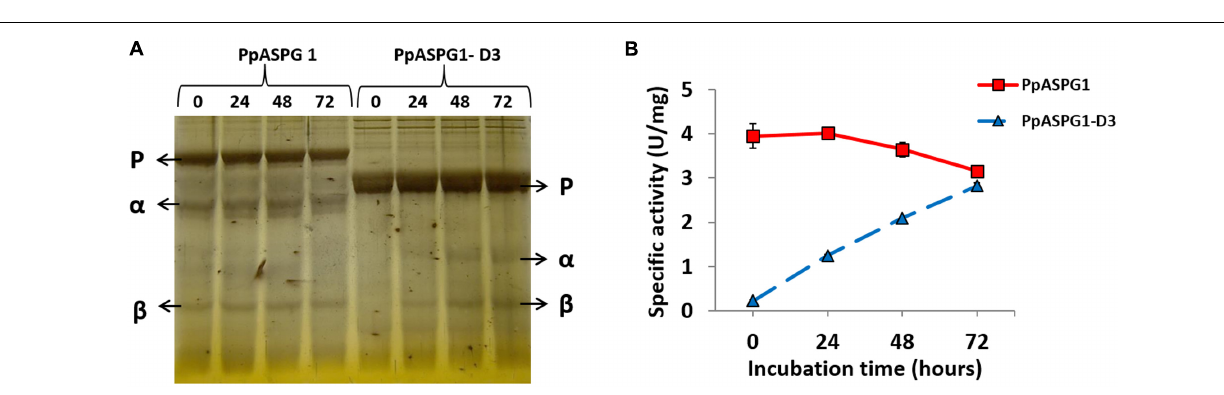
FIGURE 5 | Elimination of the VL allows in vitro maturation of the PpASPG1 precursor. Both recombinant proteins were expressed in E. coli cells and recovered from inclusion bodies. The purified recombinant proteins were incubated at room temperature during three consecutive days in the presence of KCl 50 mM and aliquots were removed every 24 h and stored at –20 ◦ C until analysis. (A) Staining of the electrophoretically separated recombinant proteins. Each lane contains 5 µ g of protein and the incubation time in hours is marked on top of the lane. (B) Remaining ASPG activity was measured in the 24-h interval aliquots for both proteins. Values are the means of three independent replicates ± SD. The specific activity values of PpASPG1 at 24, 48, and 72 h are not significantly different of the respective previous value according to t -tests ( p < 0.01). The specific activity values of PpASPG1-D3 at 24, 48, and 72 h are significantly different of the respective previous value according to t -tests ( p <